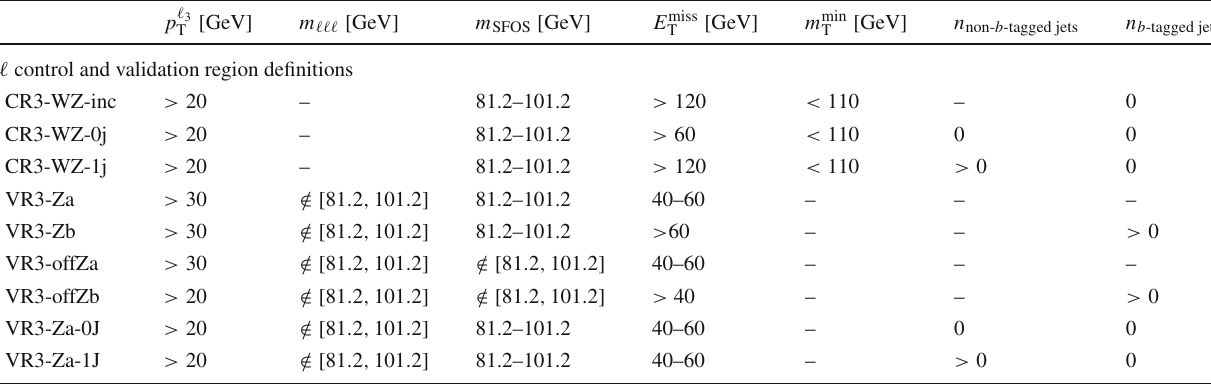
Table 7 Control and validation region definitions used in the 3 (cid:4) channel. The m SFOS quantity is the mass of the same-flavour opposite-sign lepton pair and m (cid:4)(cid:4)(cid:4) is the trilepton invariant mass. Other symbols and abbreviations are analogous to those in Table